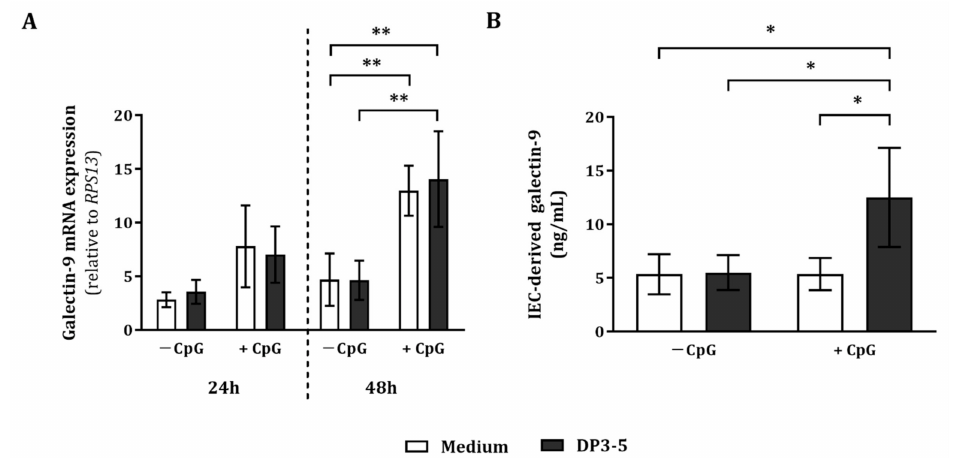
Figure 4. Galectin-9 mRNA expression and IEC-derived galectin-9 release. After IEC/PBMC co- culture, IEC were collected and galectin-9 mRNA expression was measured ( A ). Alternatively, IEC were washed and incubated in fresh medium for an additional 24 h (48 h in total; 24 h in IEC/PBMC co-culture and an additional 24 h in IEC culture in fresh medium), after which IEC and the basolateral supernatant were collected. The relative galectin-9 mRNA abundance at 24 h and 48 h ( A ) and the IEC-derived galectin-9 secretion at 48 h ( B ) were analyzed. Data represent mean ± SEM of n = 3 and n = 6 independent PBMC donors for ( A , B ), respectively (* p < 0.05, ** p <